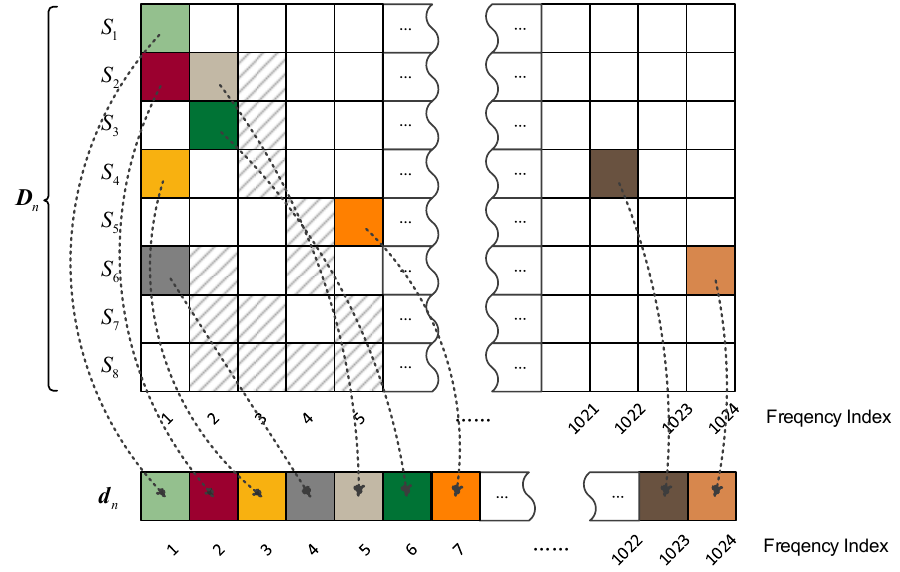
Figure 2. Example of TF (Time-Frequency) instants extraction and de-mixing procedure with eight unique simultaneously occurring sources .